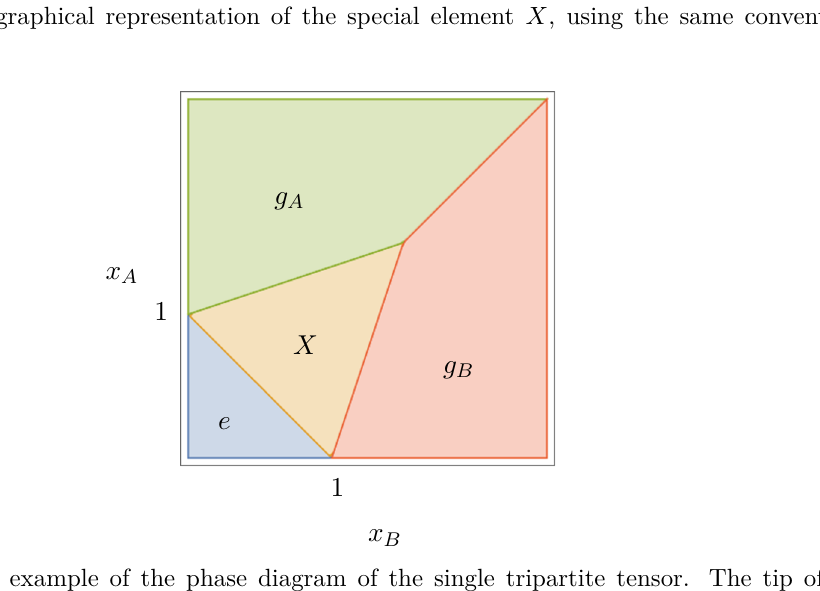
Figure 9 . An example of the phase diagram of the single tripartite tensor. The tip of the X triangle lies at ( n/ 2 , n/ 2)